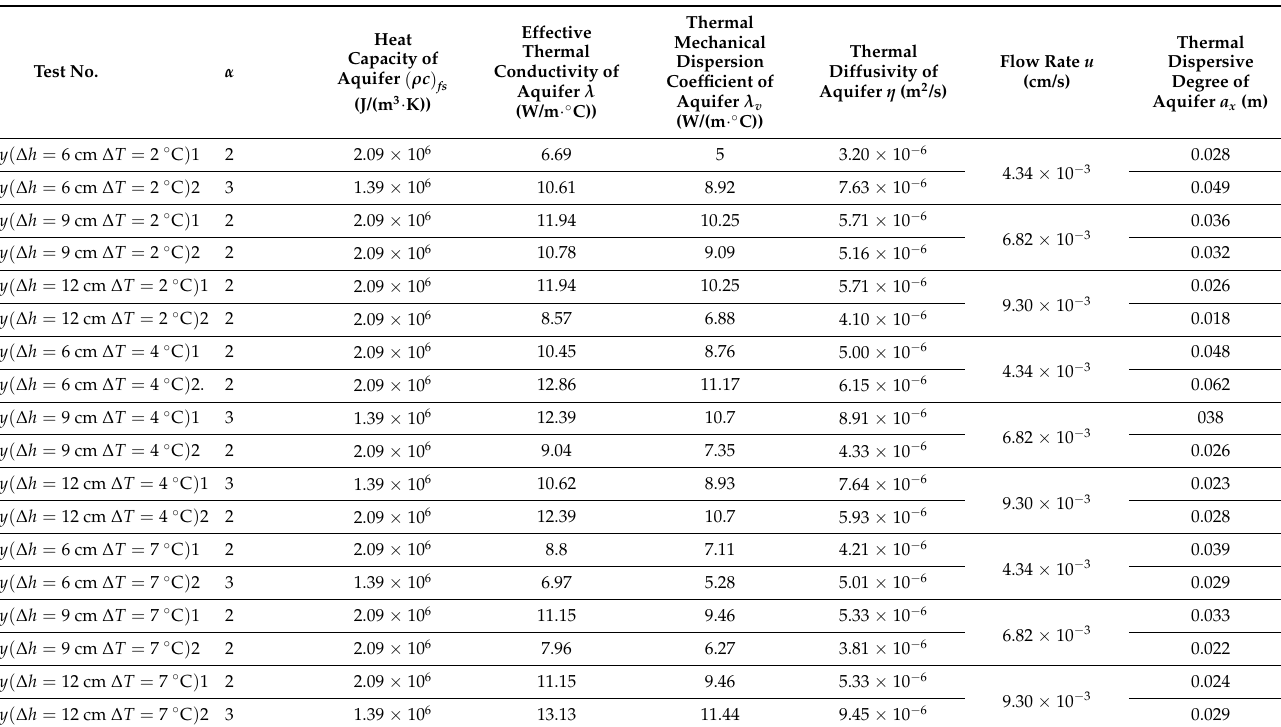
Table 4. Calculation results of the thermal property parameters of aquifer by the slug heat test method in the case of u (cid:54) = 0.